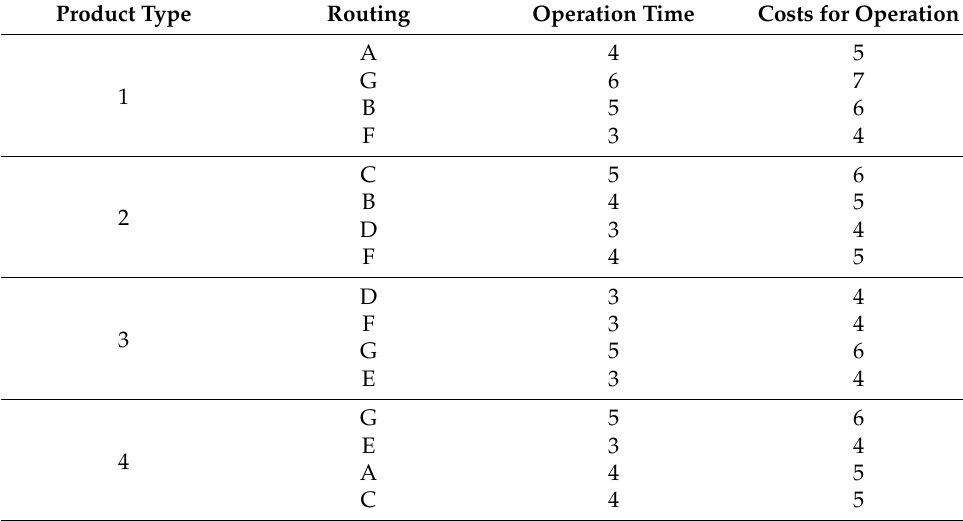
Table 3. Values of internal system parameters.